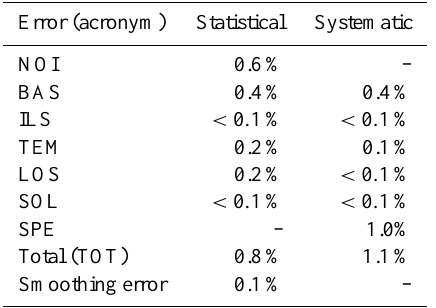
Table 3. Statistical and systematic errors in the Iza˜na total H 2 O column due to the assumed experimental and temperature uncer- tainty sources of Table 2. The “Total (TOT)” data represent the root- square-sums of these errors. In addition, the error due to the limited vertical sensitivity and resolution of the remote sensing system is given (smoothing